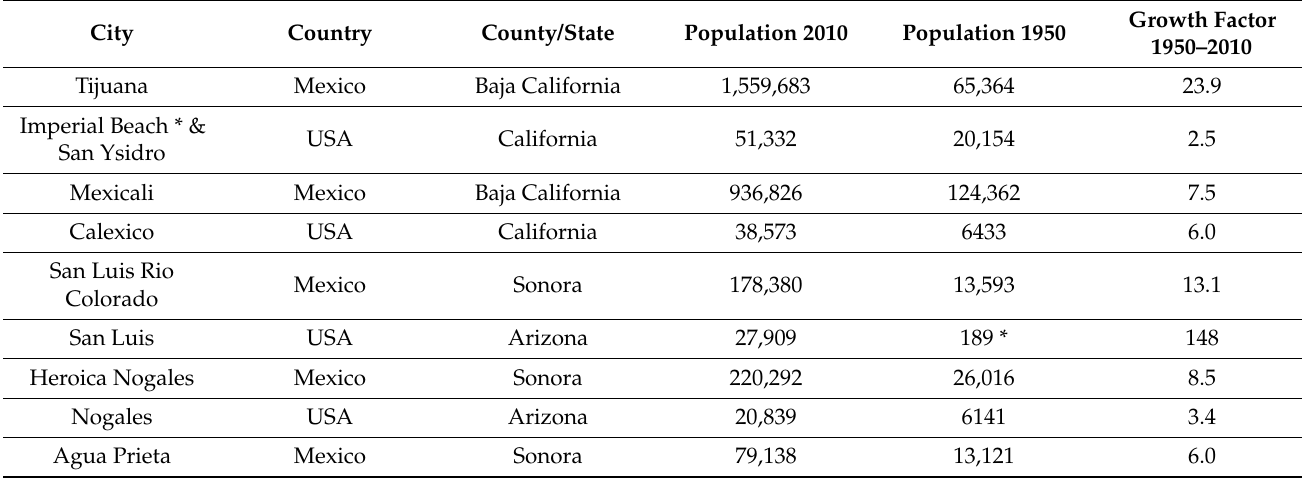
Table 3. Analyzing urban growth of the cities along the Mexican-US border, based on census data (data sources: microregiones.gob.mx; inegi.org.mx; census.gov; texasalmanac.com, all accessed on 30 September